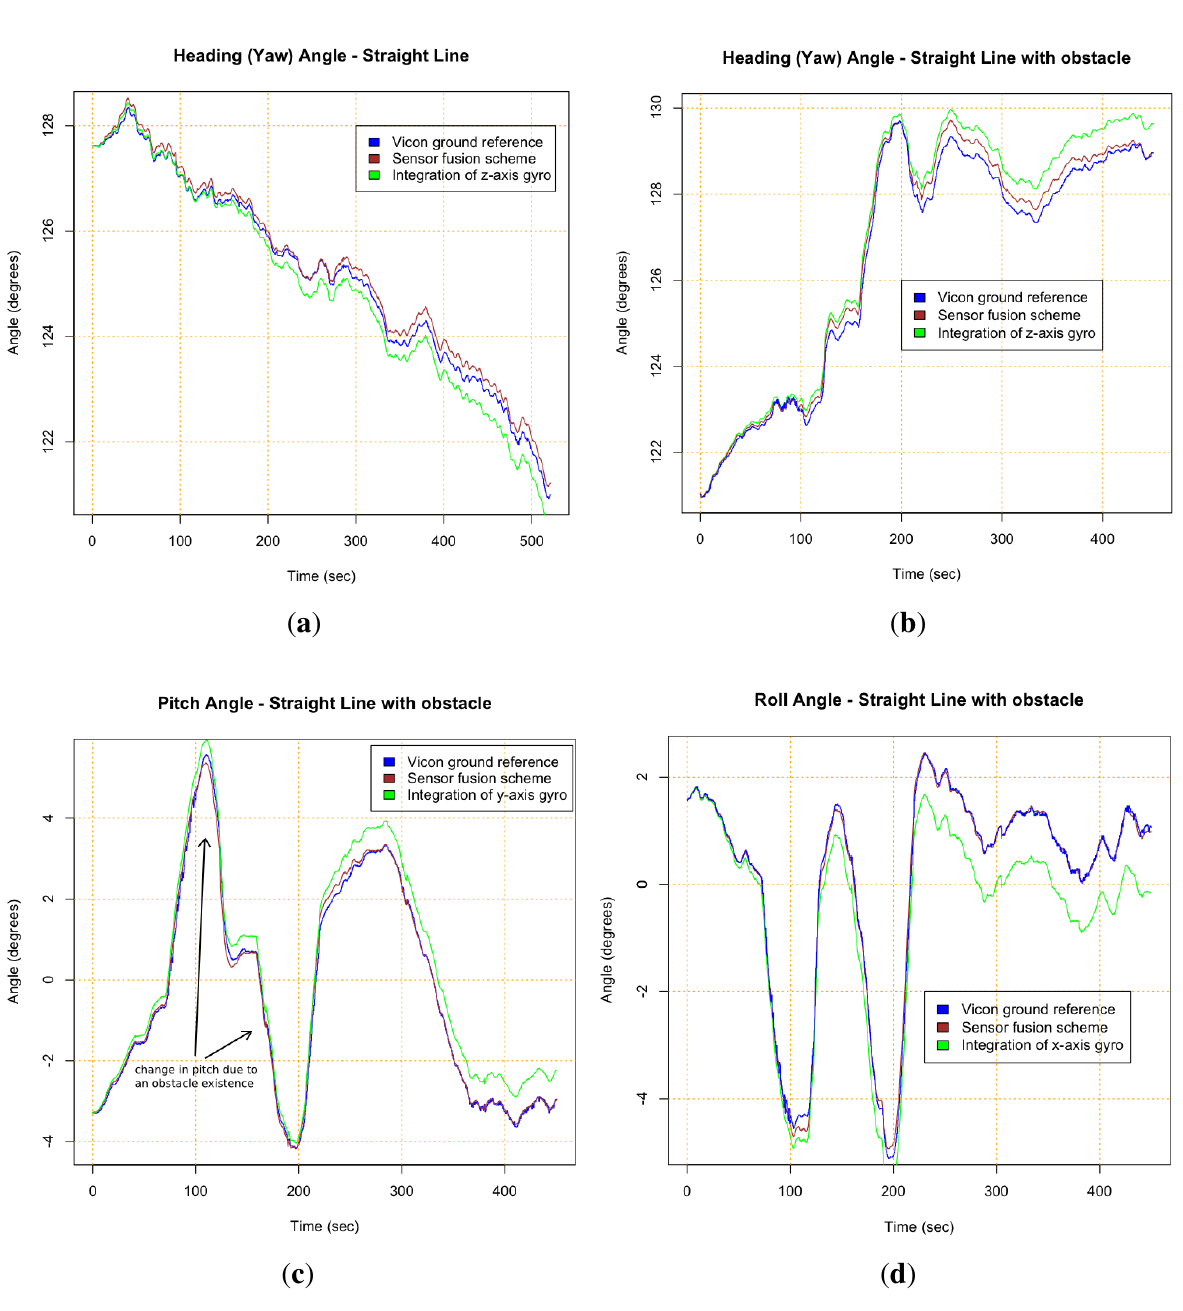
Figure 9. Results of the proposed approach for straight line tests. ( a ) Heading for straight path test; ( b ) Heading for straight path test with boulder negotiation; ( c ) Pitch for straight path test with boulder negotiation; ( d ) Roll for straight path test with boulder